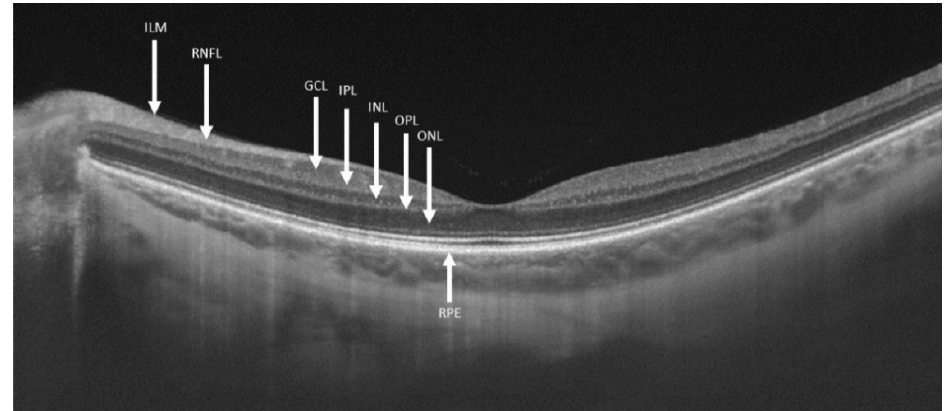
Figure 1. Segmentations of retinal layers in swept-source optical coherence tomography. Abbreviations: ILM—inner limiting membrane; RNFL—retinal nerve fiber layer; GCL—ganglion cell layer;